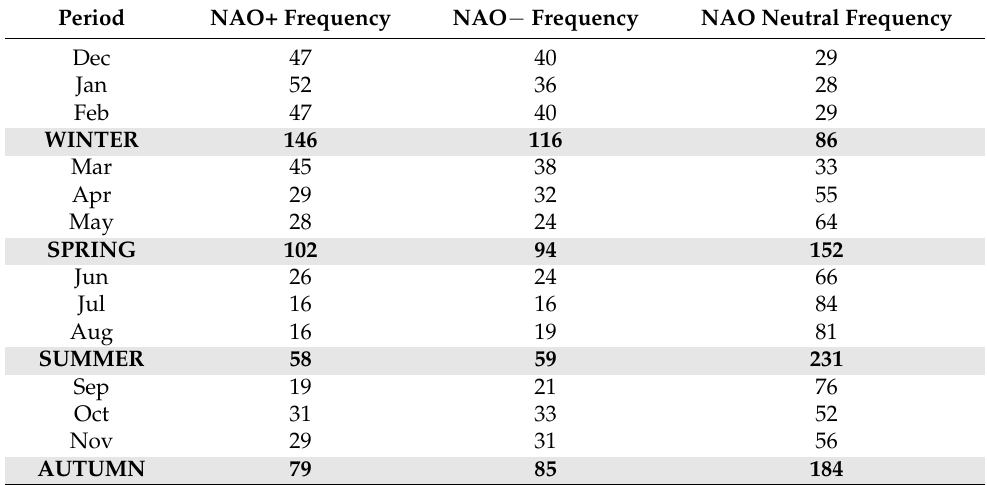
Table 1. Frequency Distribution of NAO Phases per Month (January 1900–December 2015).